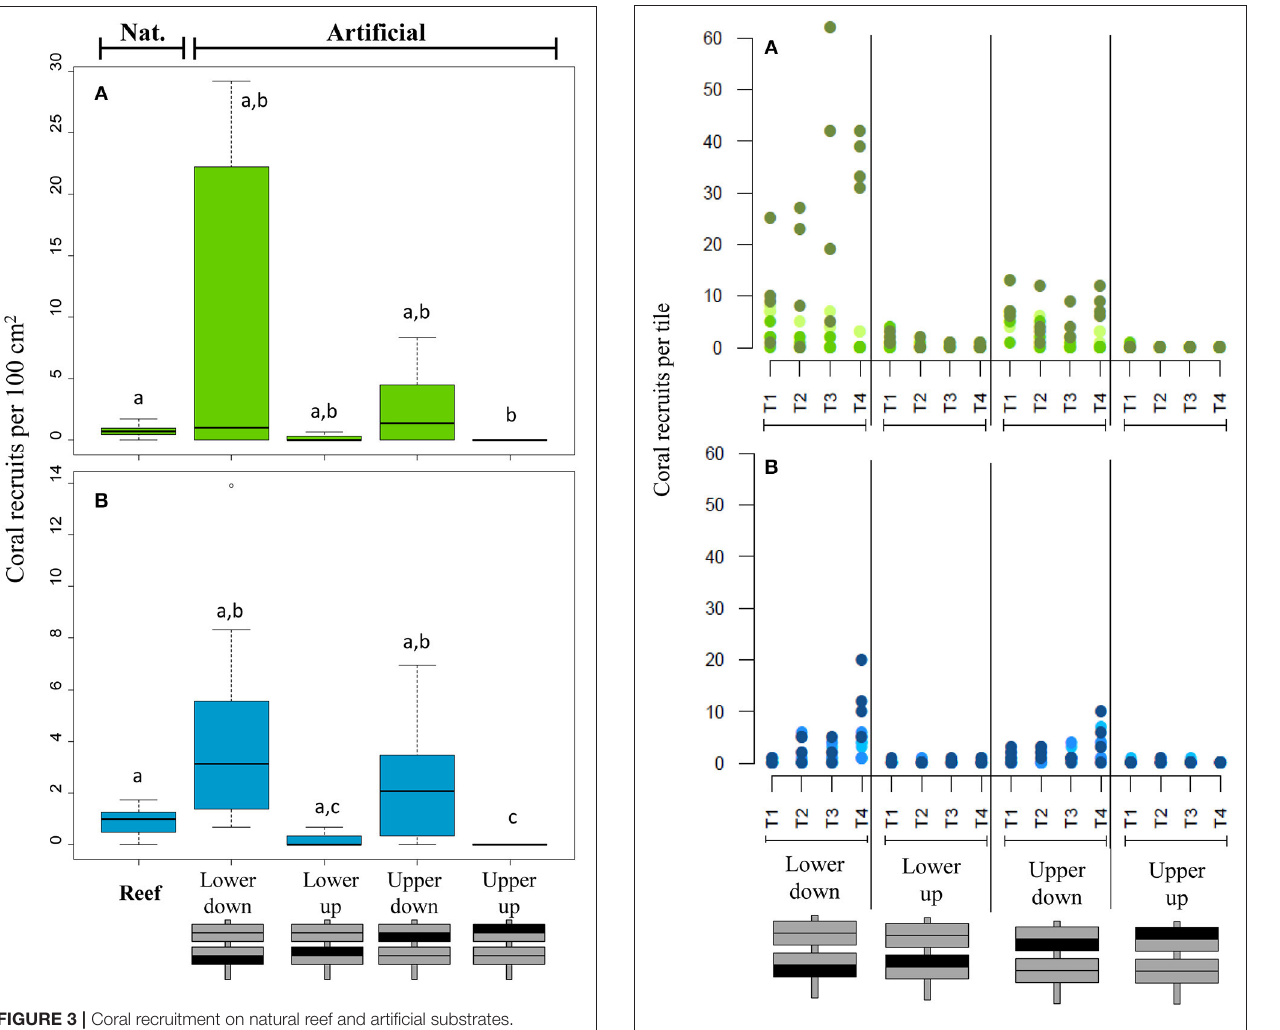
FIGURE 4 | Temporal settlement pattern of coral recruits on artificial tiles. (A) shows recruit numbers at the near-shore site (BL), (B) at the mid-shelf site (BD). T1 to T4 represent the different sampling times, T1 = 2 weeks, T2 = 4 weeks, T3 = 6 weeks, T4 = 8 weeks. Recruit numbers are organized per surface orientation (upper and lower tile sides facing either up or down as indicated on the schematic). Different colors indicate measurements from the three different experimental